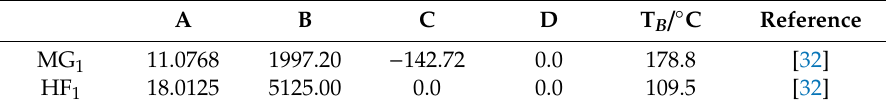
Table 6. Correlation parameters of the vapor pressure equation (Equation (8)) and normal boiling points ( T B ) of HF 1 and MG 1 .